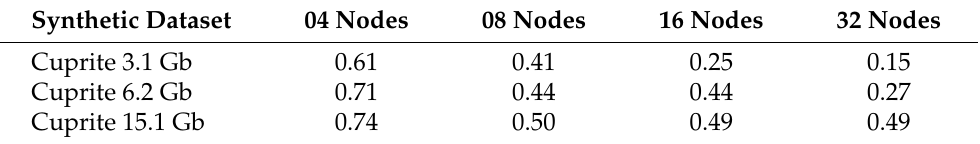
Table 4. Proportional speedup increments for each node configuration on the cloud environment. Synthetic